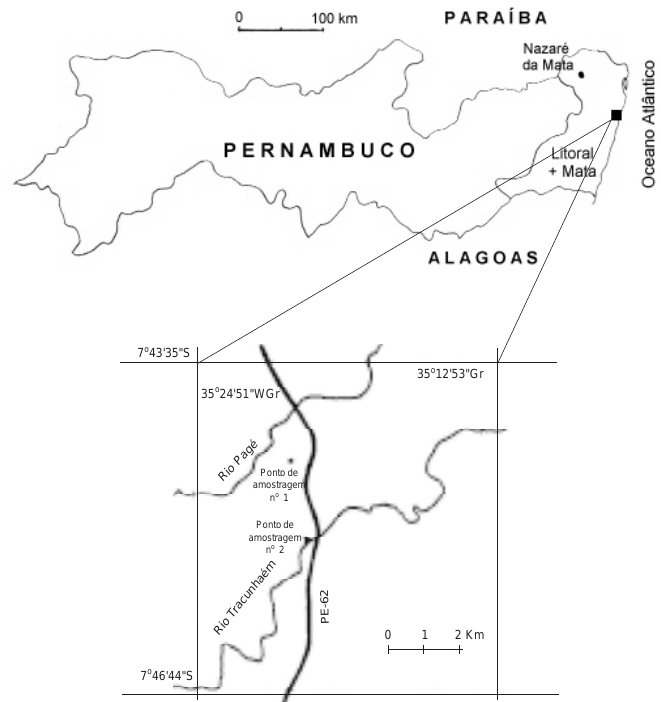
Figura 1. Localização da Área de